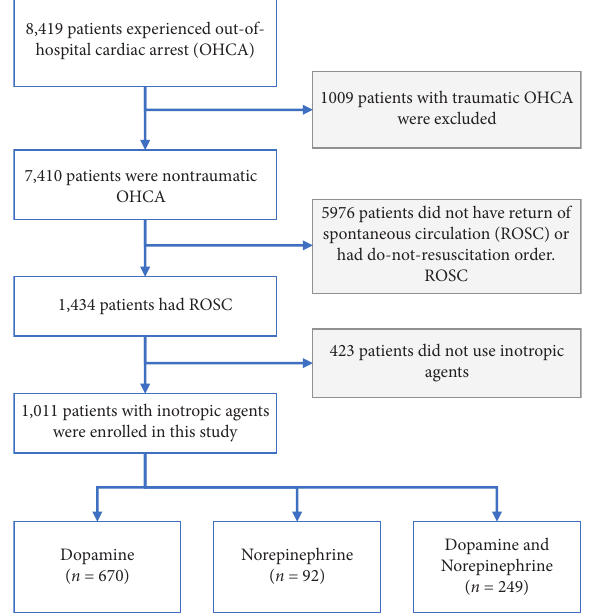
Figure 1: Flowchart of the patient selection process. The patients were included in the study based on the criteria shown above and were divided into three treatment